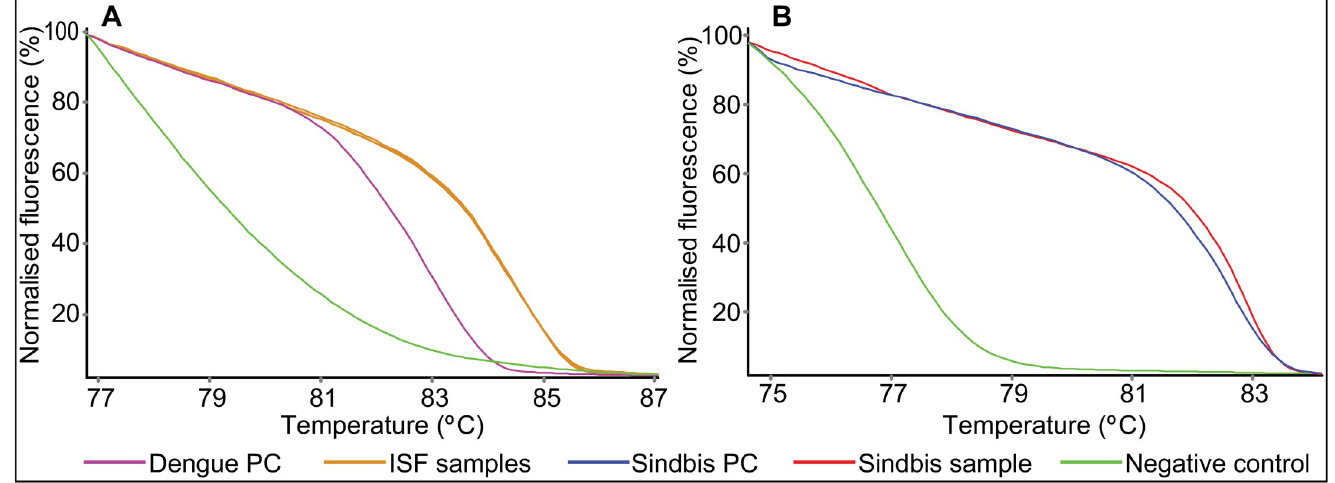
Fig 4. High-resolution melting profiles of mosquito pools with (A) insect-specific flavivirus and (B) Sindbis virus. PC = positive control.